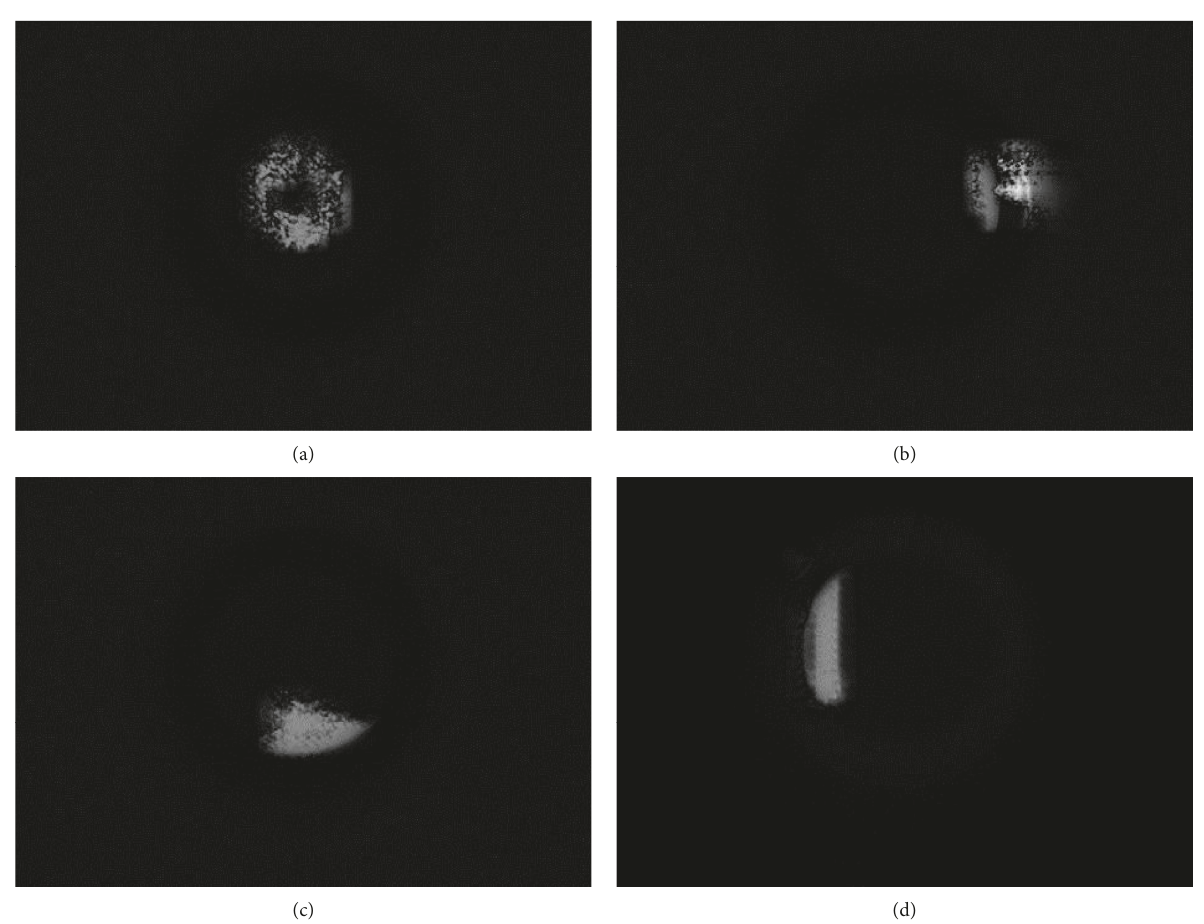
Figure 15: Result of difference operation between the reference PS and the abnormal